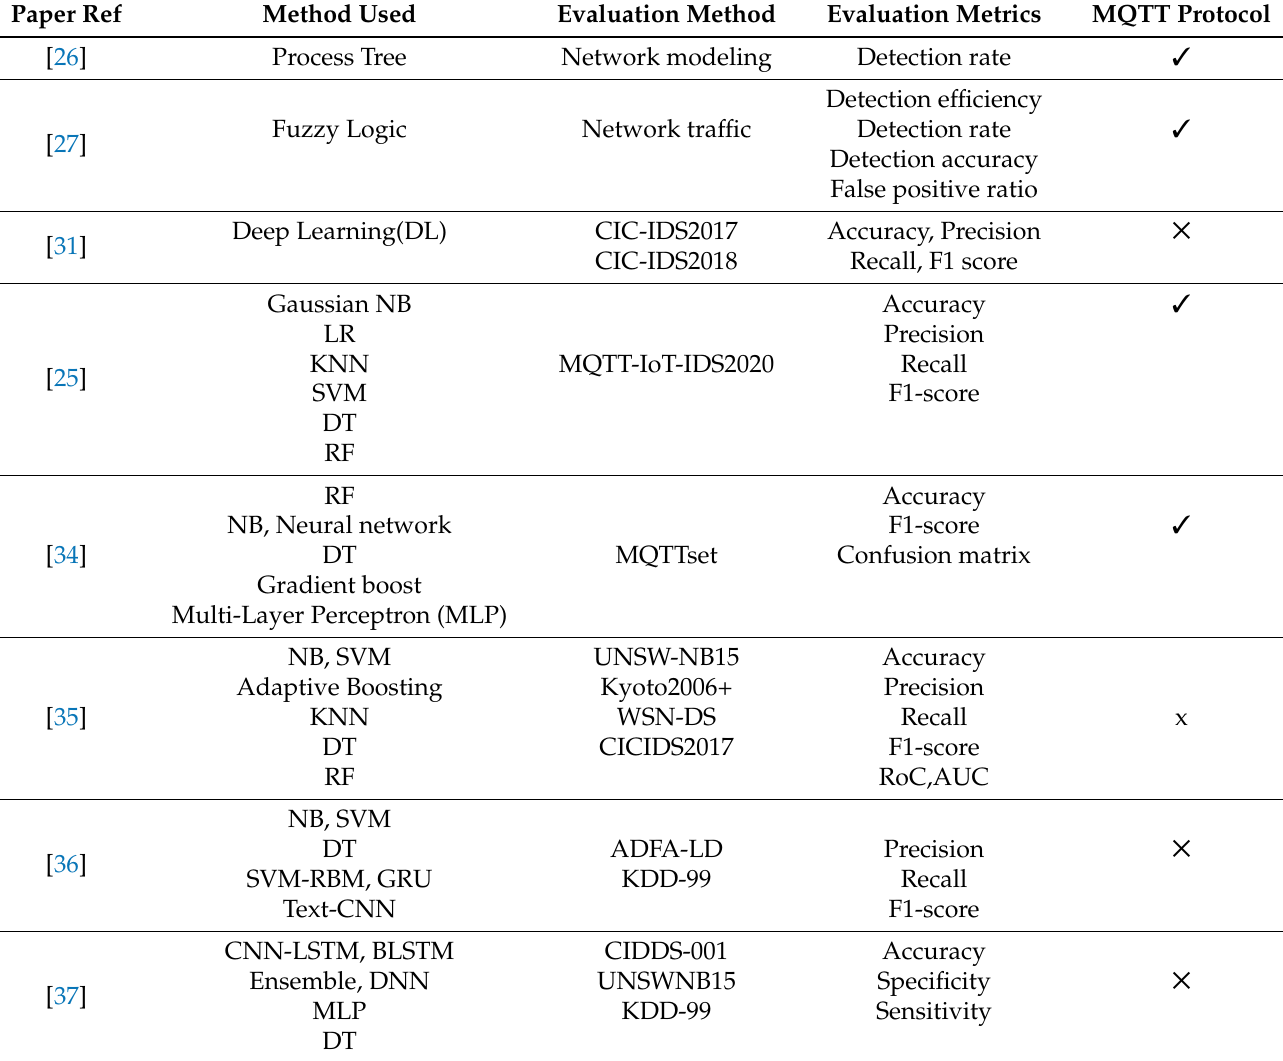
Table 1. Intrusion detection systems for MQTT